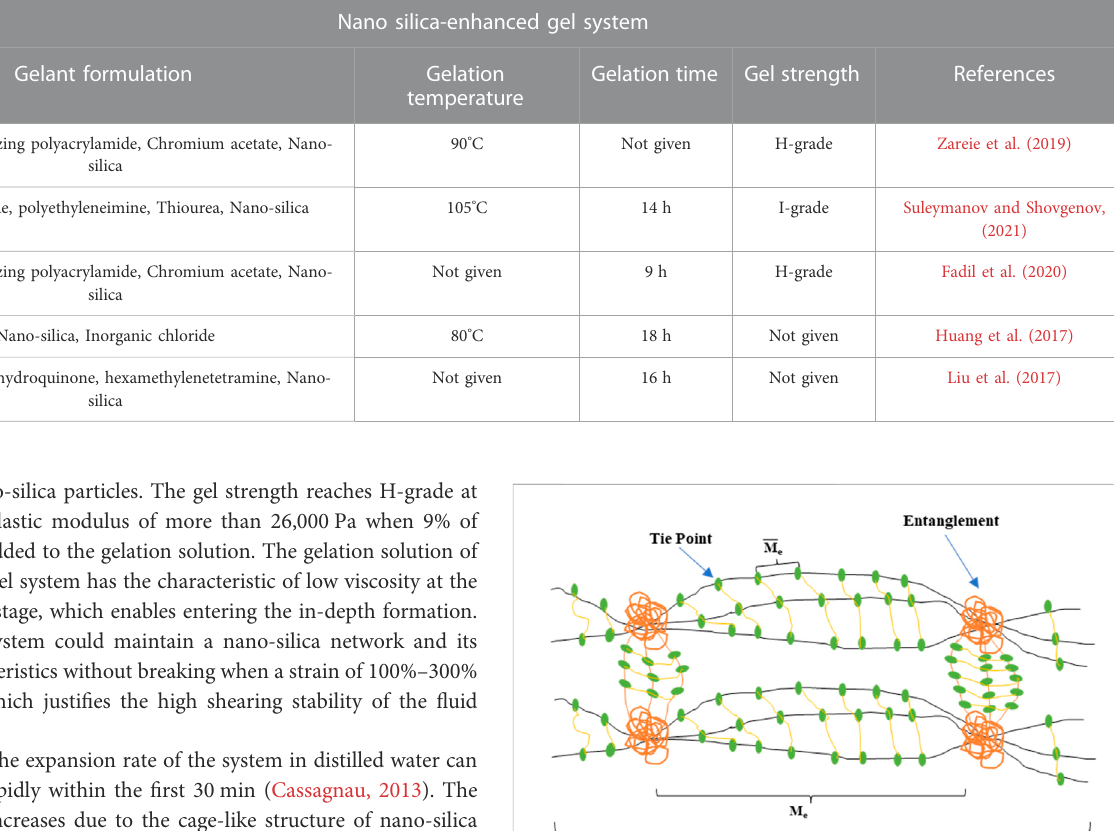
TABLE 1 Progress of nano silica-enhanced gel systems.